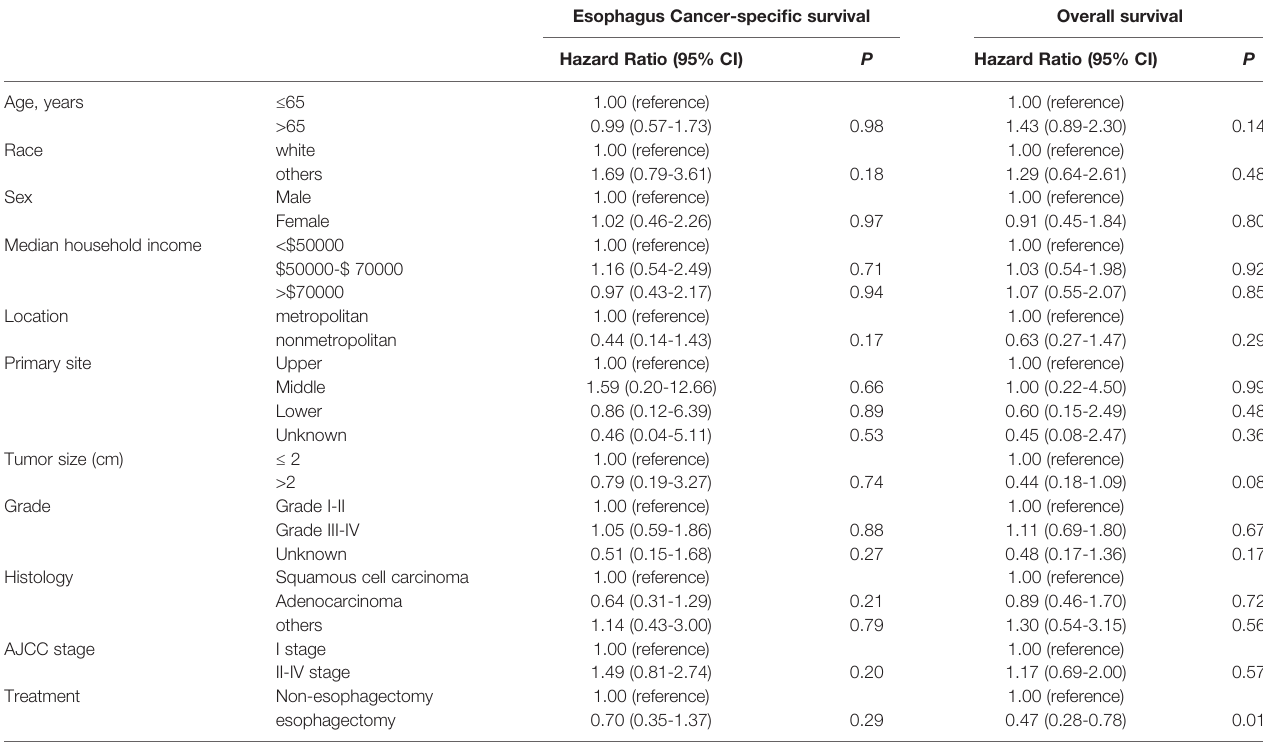
TABLE 5 | Cox proportional hazards regression model analysis for ECSS and OS in T1b stage esophagus cancer